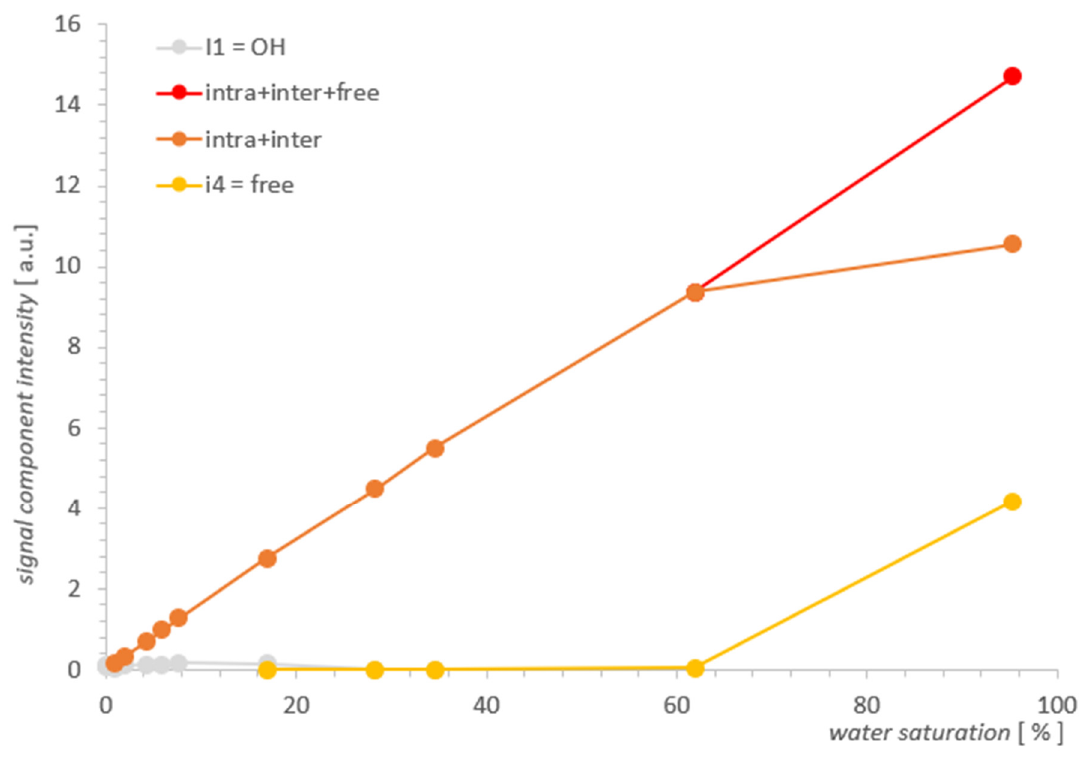
Figure 6. Individual contributions of water in SBA-15 as a function of water saturation.